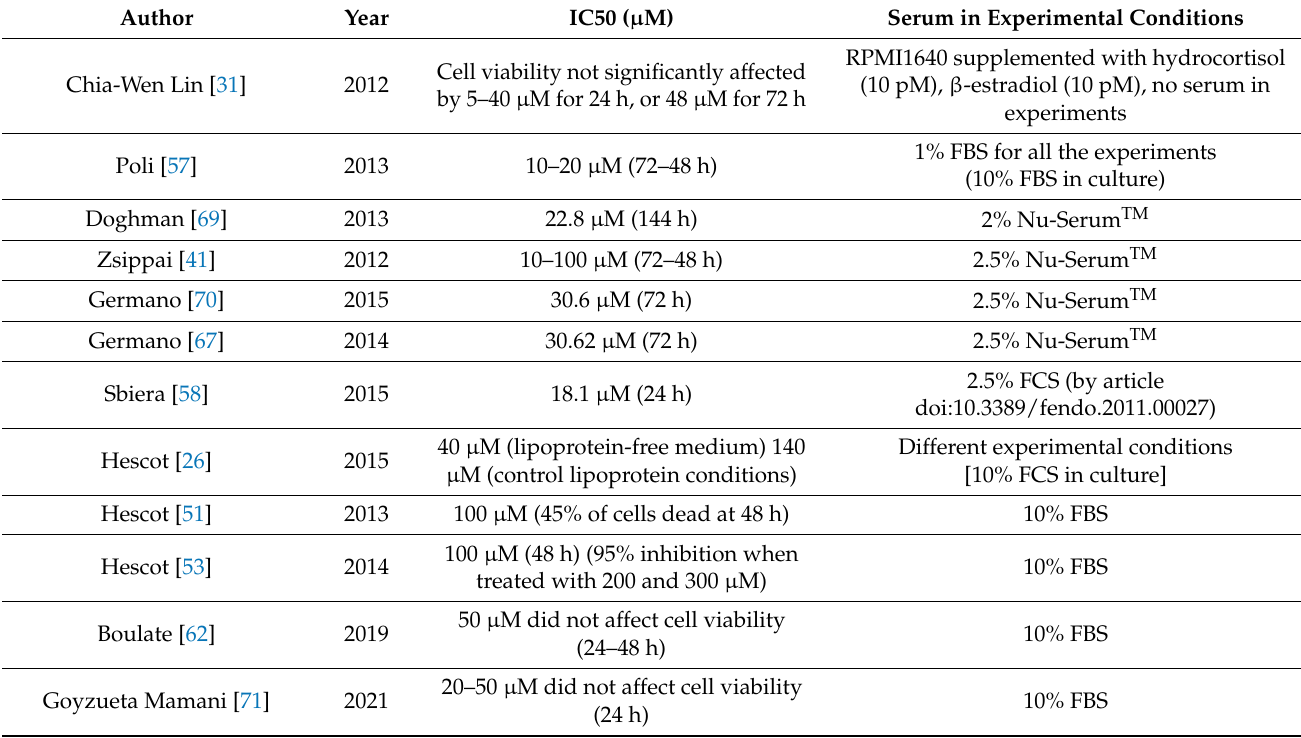
Table 1. Mitotane cytotoxicity and in vitro culture